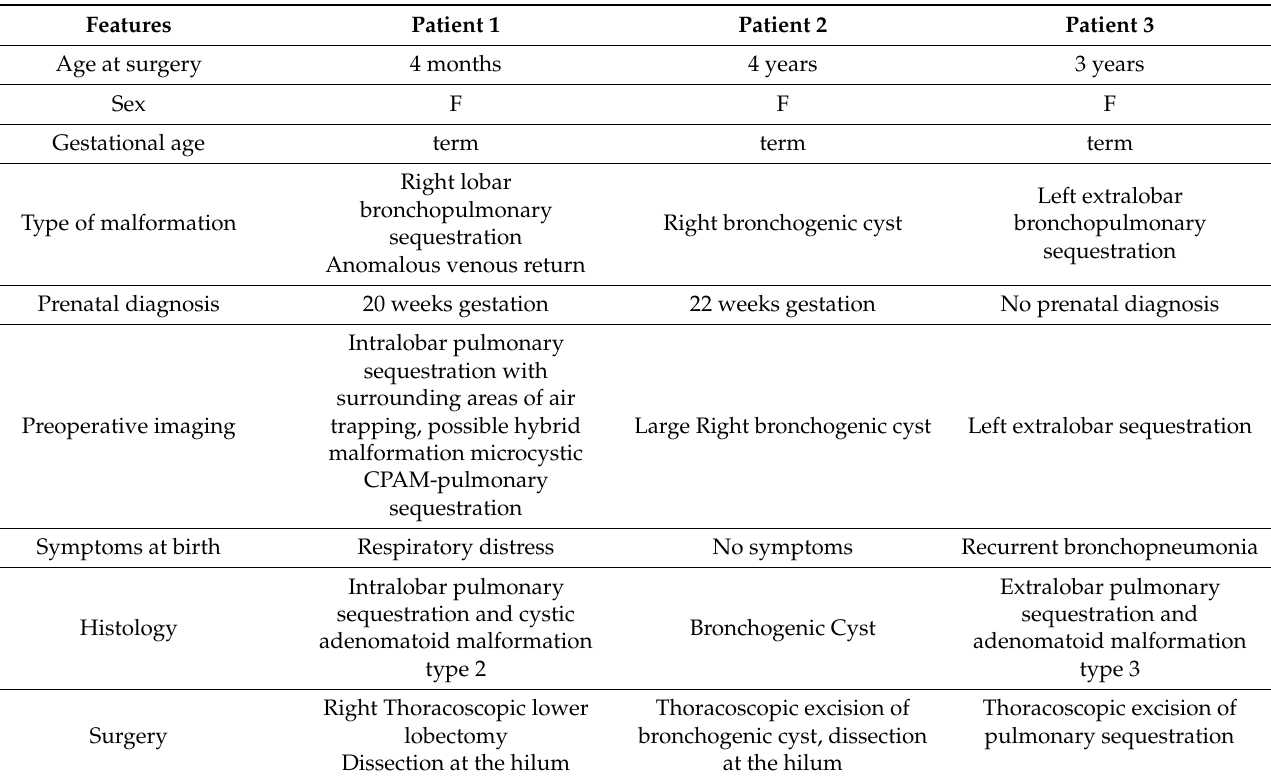
Table 1. Patient’s